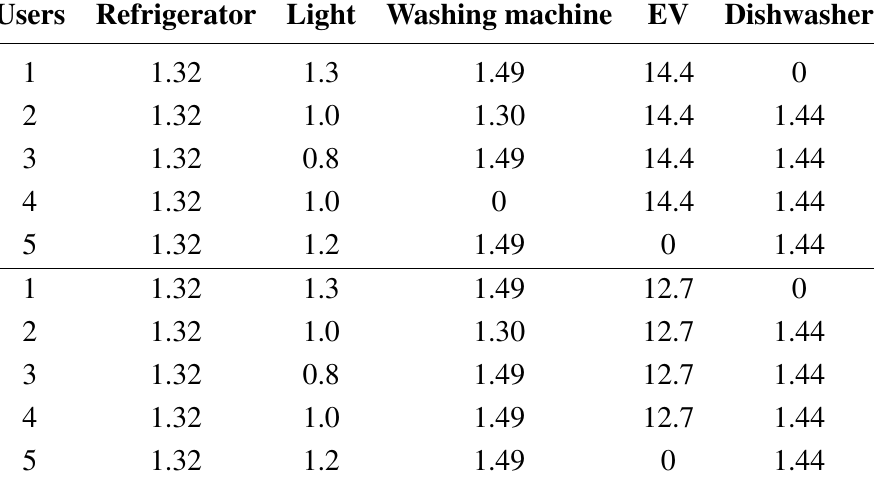
Table 1. Electricity consumption of each residential load (kW h): Friday on the top and Saturday on the bottom.